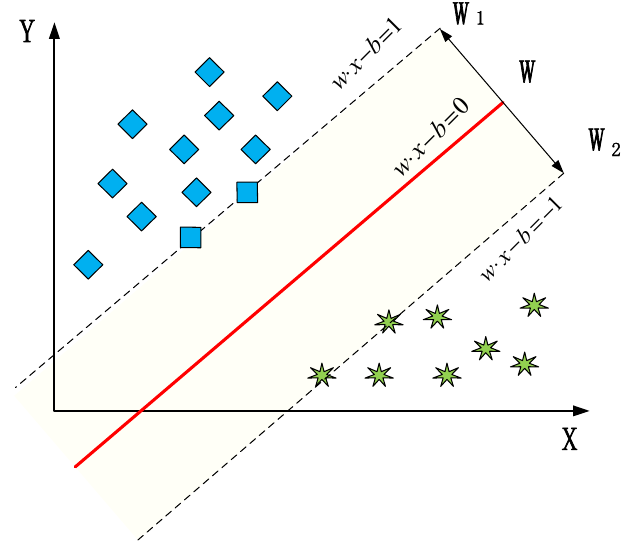
Figure 3. The optimal classified hyperplane based on the SVM.